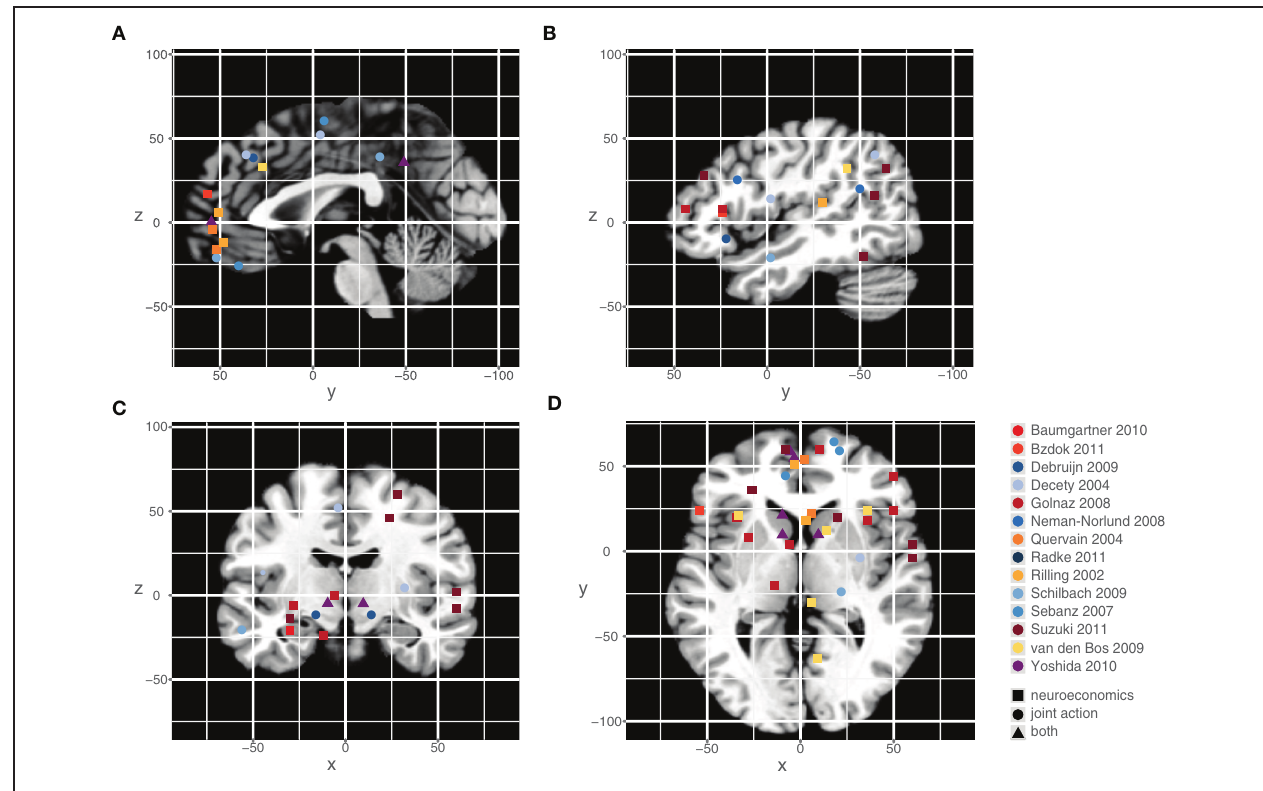
FIGURE 4 | Neural activation patterns observed in neuroeconomic and joint action imaging studies. The peak locations of the metabolic change during relevant tasks were rendered on sagittal (A,B) , coronal (C) and axial